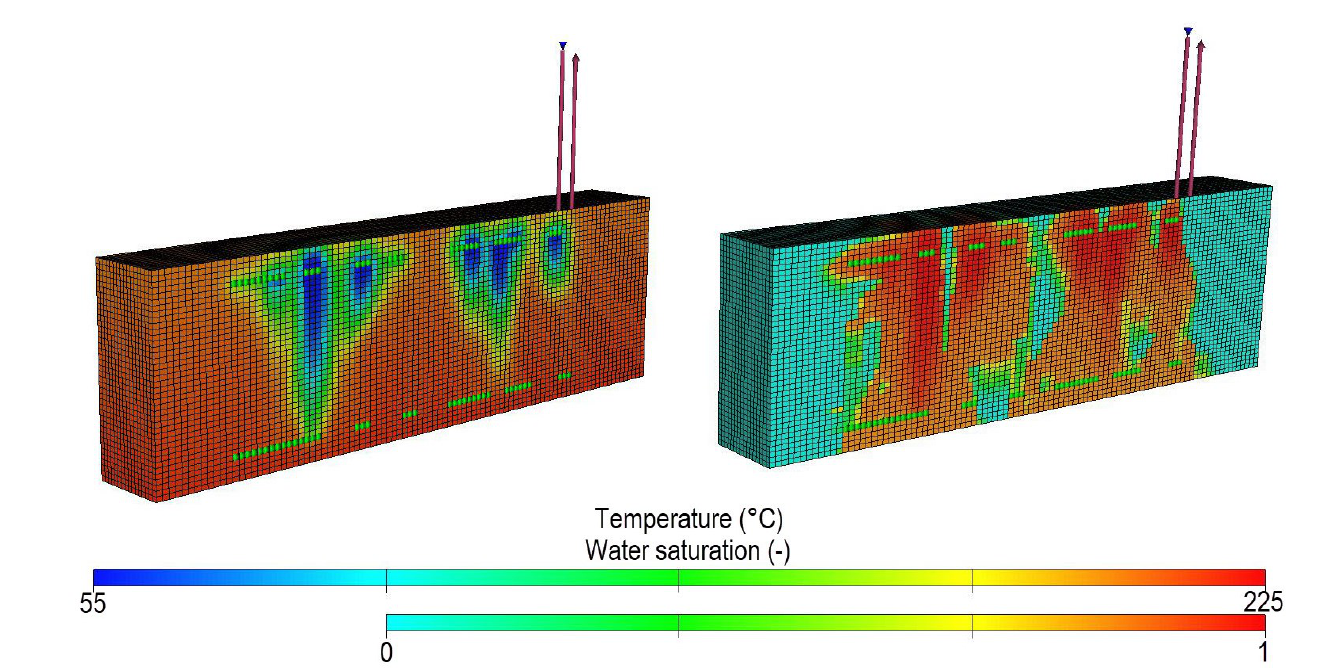
Figure 15. Temperature distribution and water saturation in SRV region after 10 years for Case VIII